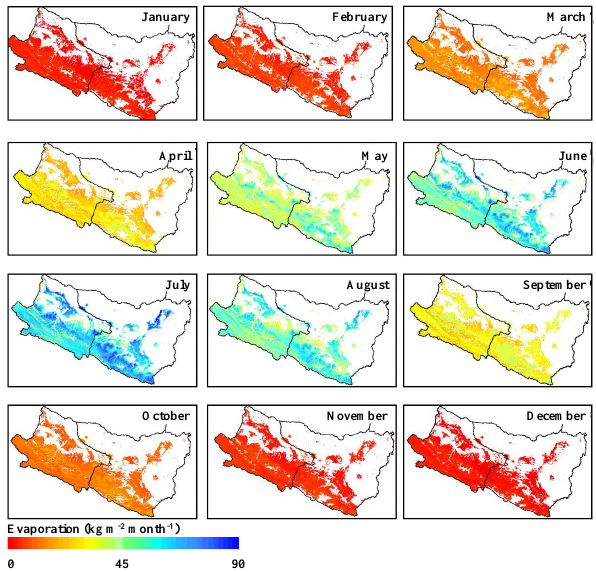
Figure 4. Ten-year average distribution of monthly evaporation (kgm − 2 month − 1 ) as a function of time of